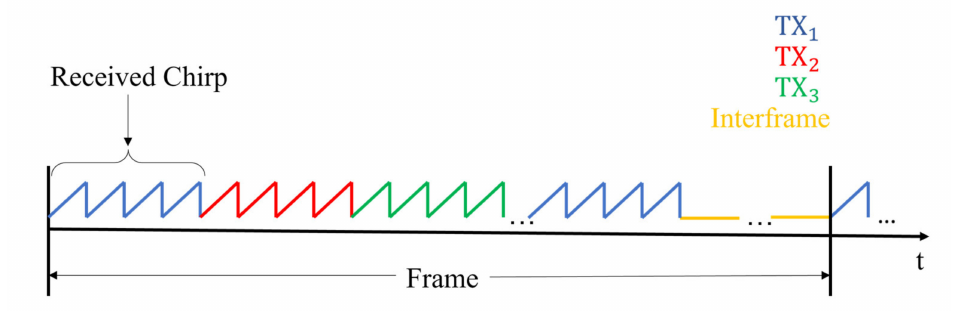
Figure 3. Working principle of 77 GHz